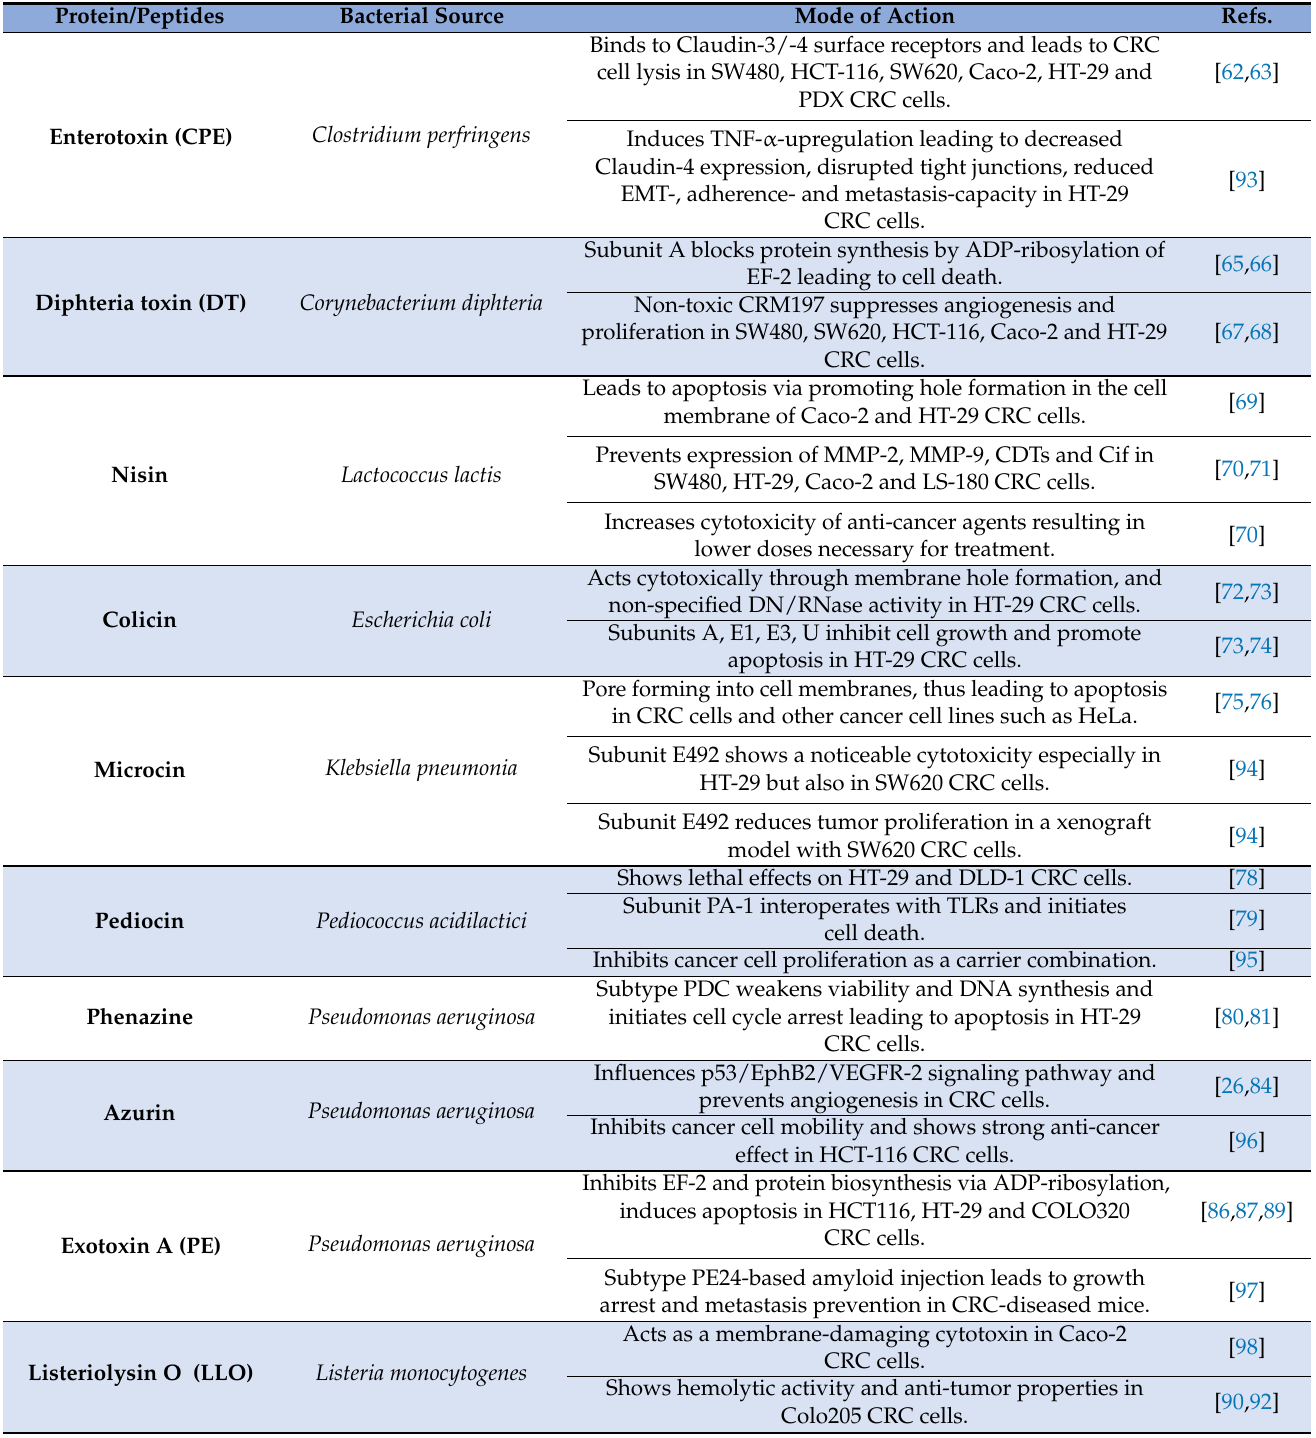
Table 1. Collection of bacterial peptides proposed for CRC